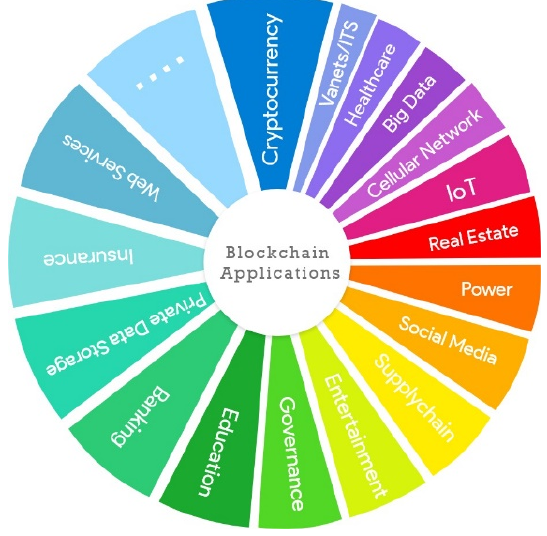
Figure 1. Applications of